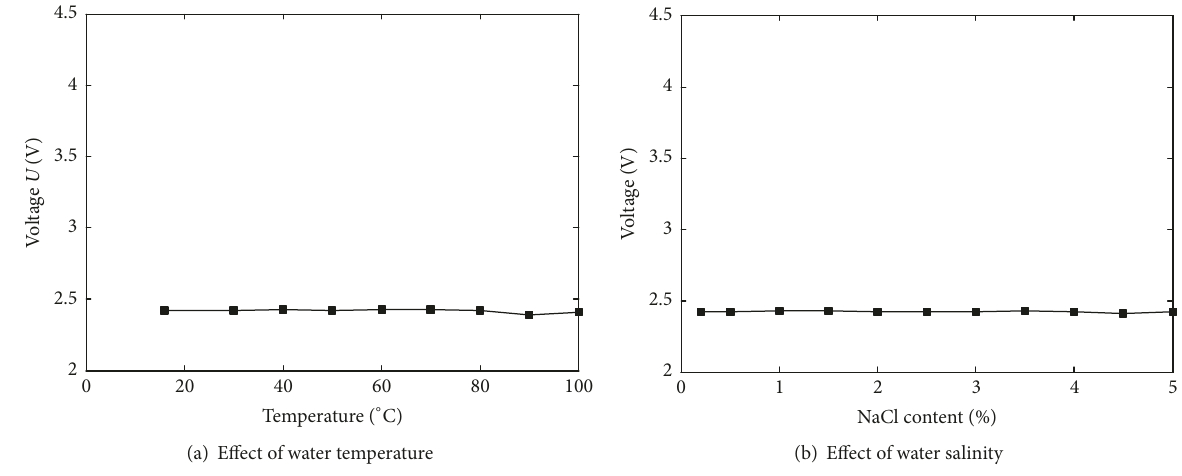
Figure 9: Effect of water properties on the probe output.